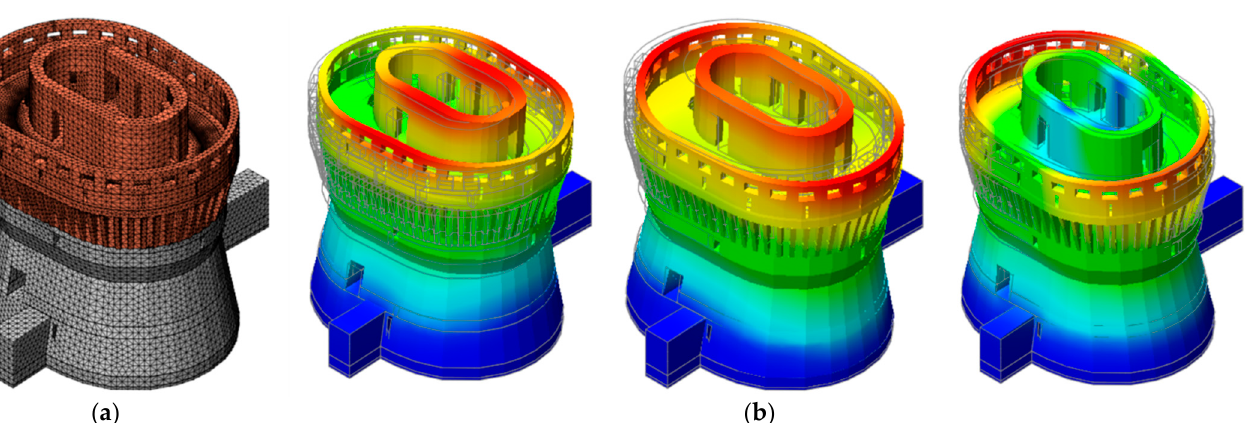
8 of 12 Figure 5. MAC between the modal vectors extracted by the 2018 and 2019 experimental campaigns with the SSI-PC method. 5. Numerical Model and Model Updating 5.1. The Finite Element Model The 3D tower geometry was sketched and meshed in the software Midas FEA [40]. Since the complexity of the structure, a macro-modeling approach was employed. The geometry discretization was obtained by using 4-nodes tetrahedral blocks elements, which are the most appropriate to approximate complex shapes, such as arches and vaults. The FEM model (see Figure 6a) was composed of 282,890 elements, 61,624 nodes and 179,925 degrees of freedom. The foundation fixed all the degrees of freedom of the base nodes. Based on the materials’ survey, two masonry types were assigned to the numerical model: full bricks with lime mortar and cut stones with good bonding among them. The materials parameters used were chosen following the Italian Code [41,42], considering a limited knowledge level (KL1), as shown in Table 2. Table 2. Materials parameters used for the starting FE model. Material